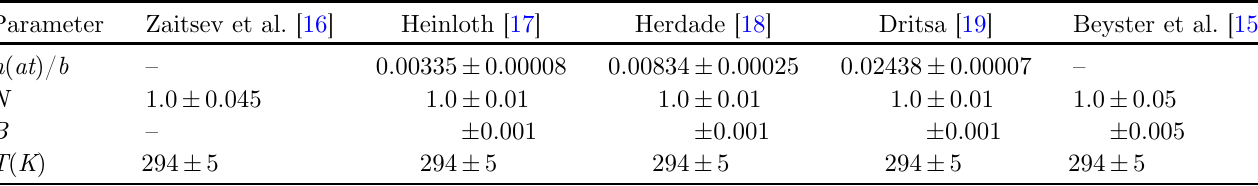
Table 3. Uncertainties on the nuisance parameters (sample area density, normalization factor, background correction, temperature) for each experimental data introduced in the CONRAD calculations.